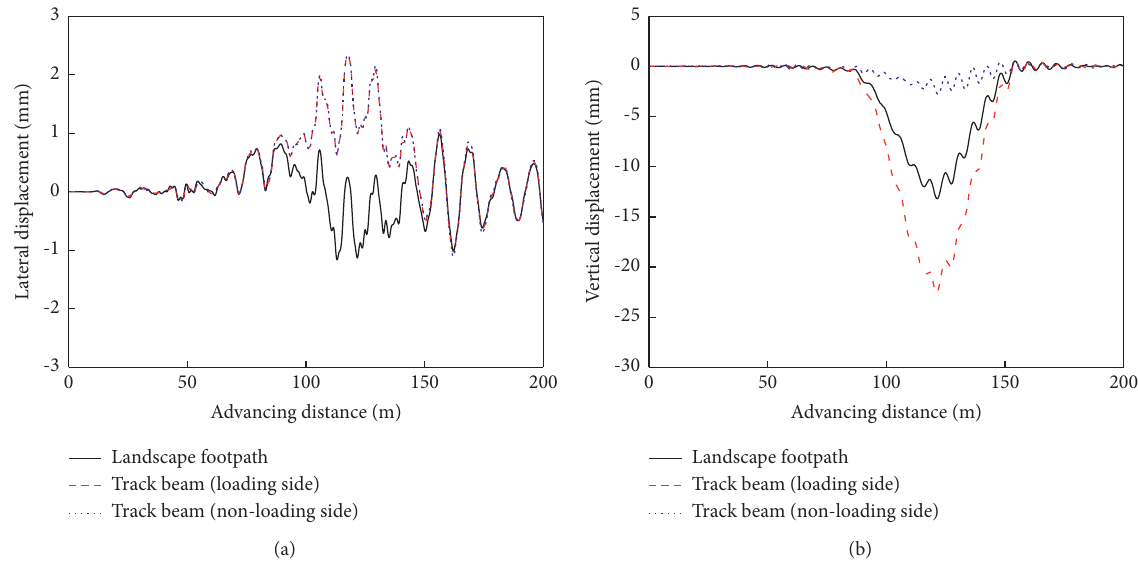
Figure 7: Comparison on time history of midspan displacements of landscape footpath and track beam. (a) Lateral. (b)